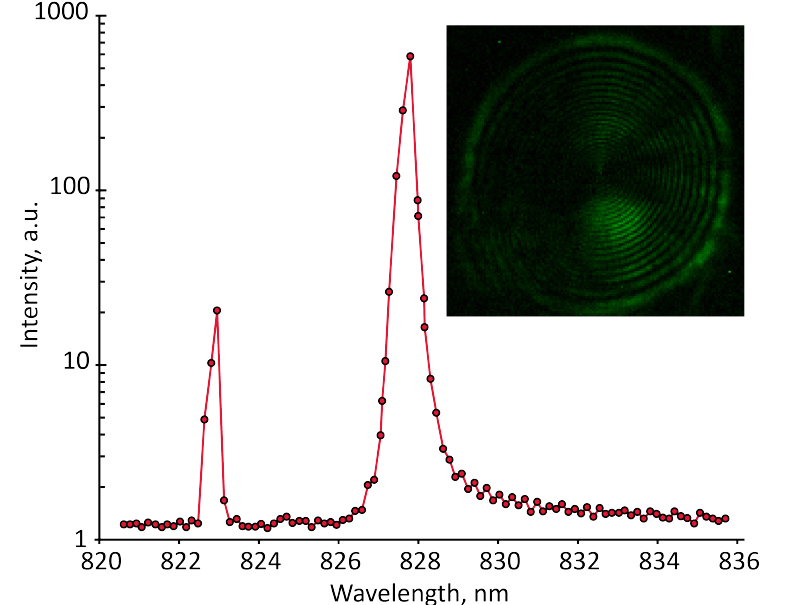
Figure 3. The IR CE spectrum in logarithmic scale and a far-field-zone CE image (in the insert). The dots are the spectrometer CCD array readings. Intensity of the inner rings (insert) was magnified by a factor of